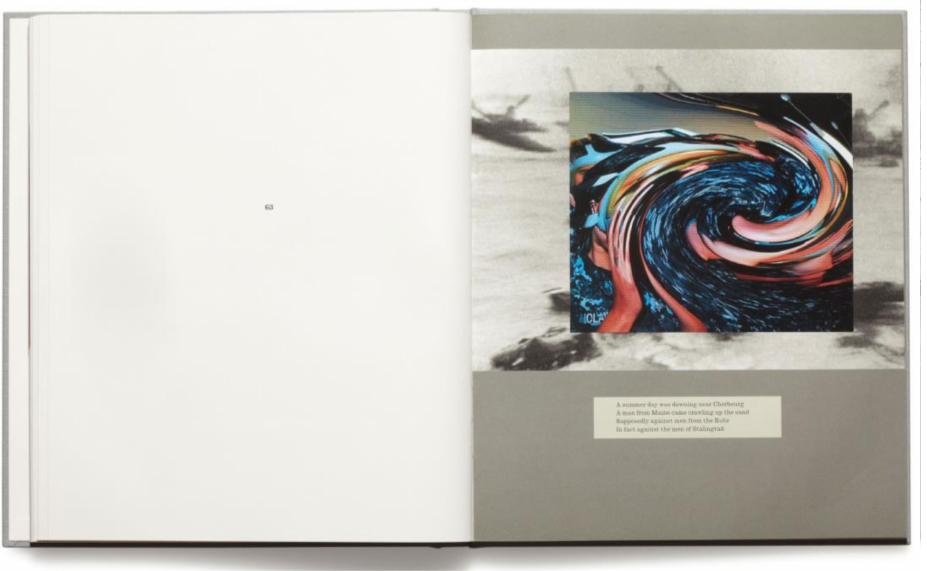
Figure 5. Broomberg & Chanarin. 2011. War Primer 2 . London: Mack. Plate 63. 51